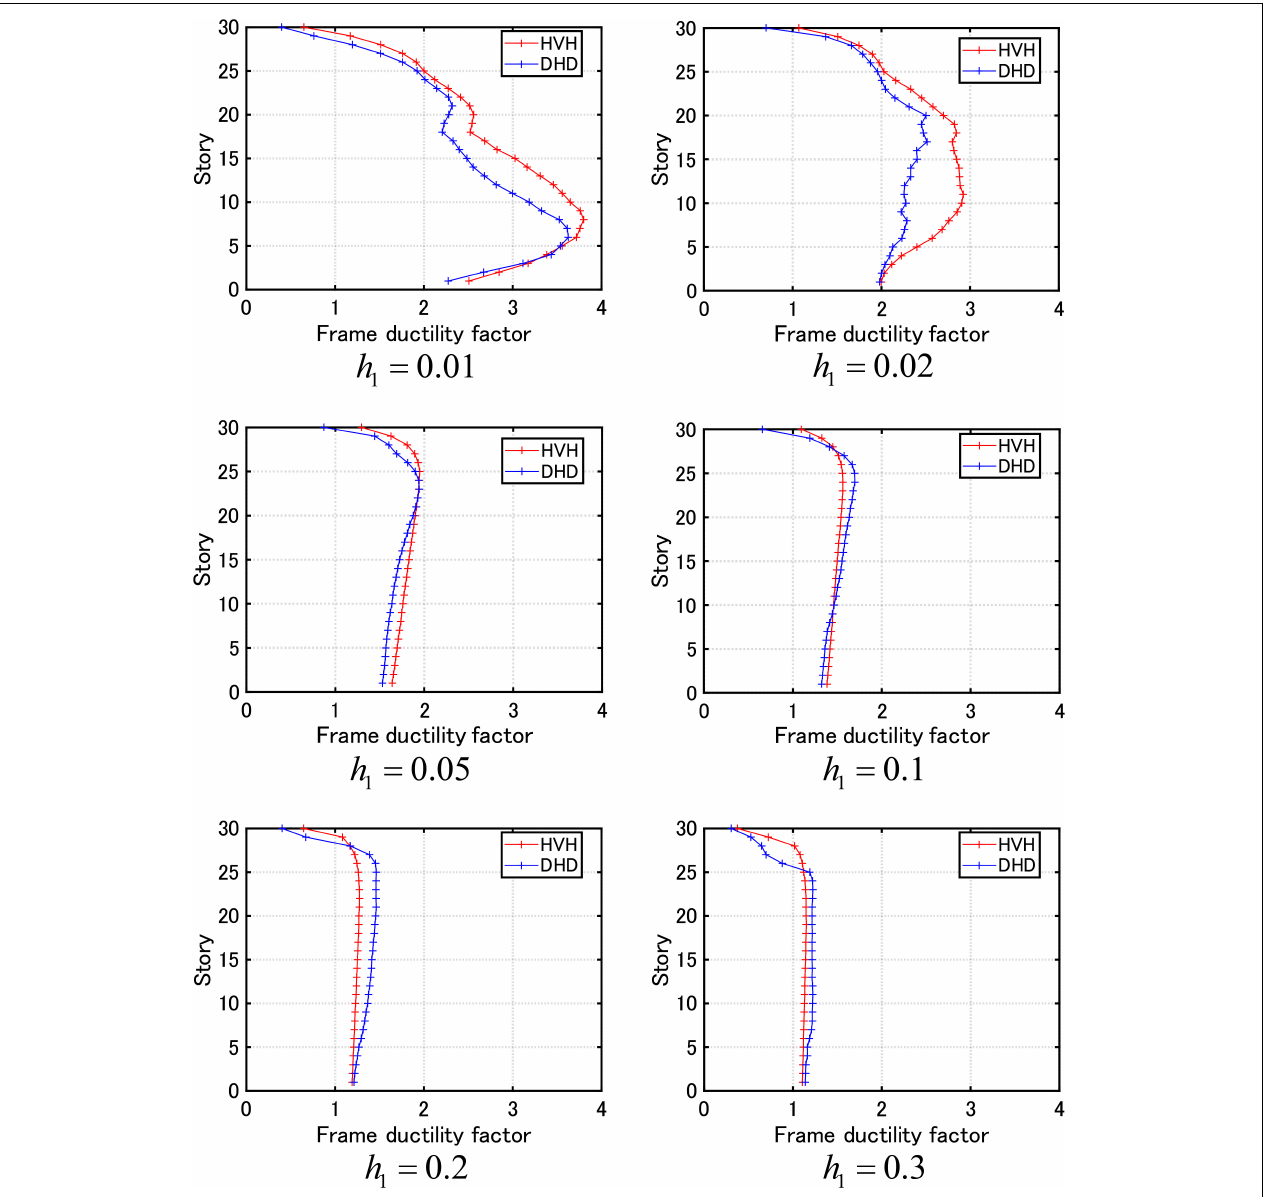
FIGURE 7 | Frame ductility factor distribution of inter-story drift in MDOF systems with HVH system for various damping levels h 1 = 0 . 01 , 0 . 02 , 0 . 05 , 0 . 1 , 0 . 2 , 0 . 3 of viscous dampers and with DHD system of equivalent damper quantity of DSA (using Eq. (18)) under critical double impulse with V = 2.0